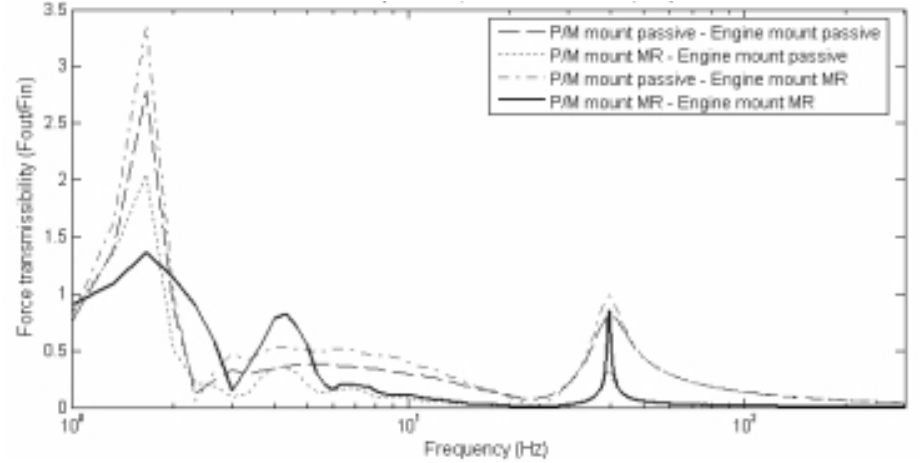
Fig. 10. Force transmissibility through the hydraulic subsystem (HSS) mounts to the